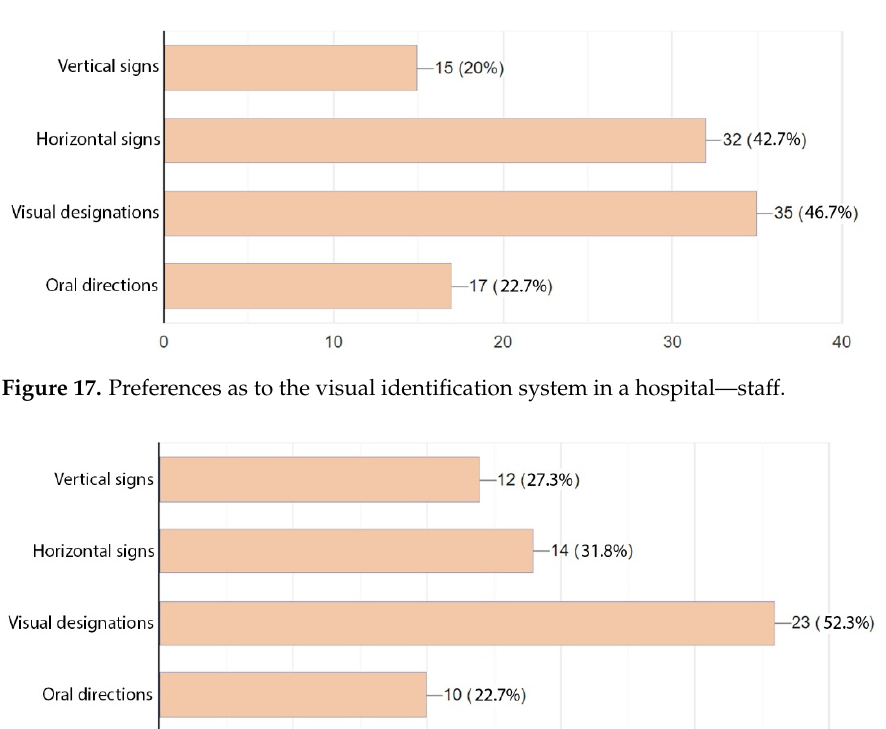
Figure 18. Preferences as to the visual identification system in a